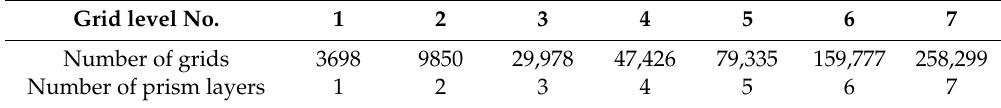
Figure 8. Sectional view of the grids at the mid-symmetry plane: ( a ) grid level 1; ( b ) grid level 4; ( c ) grid level 7.